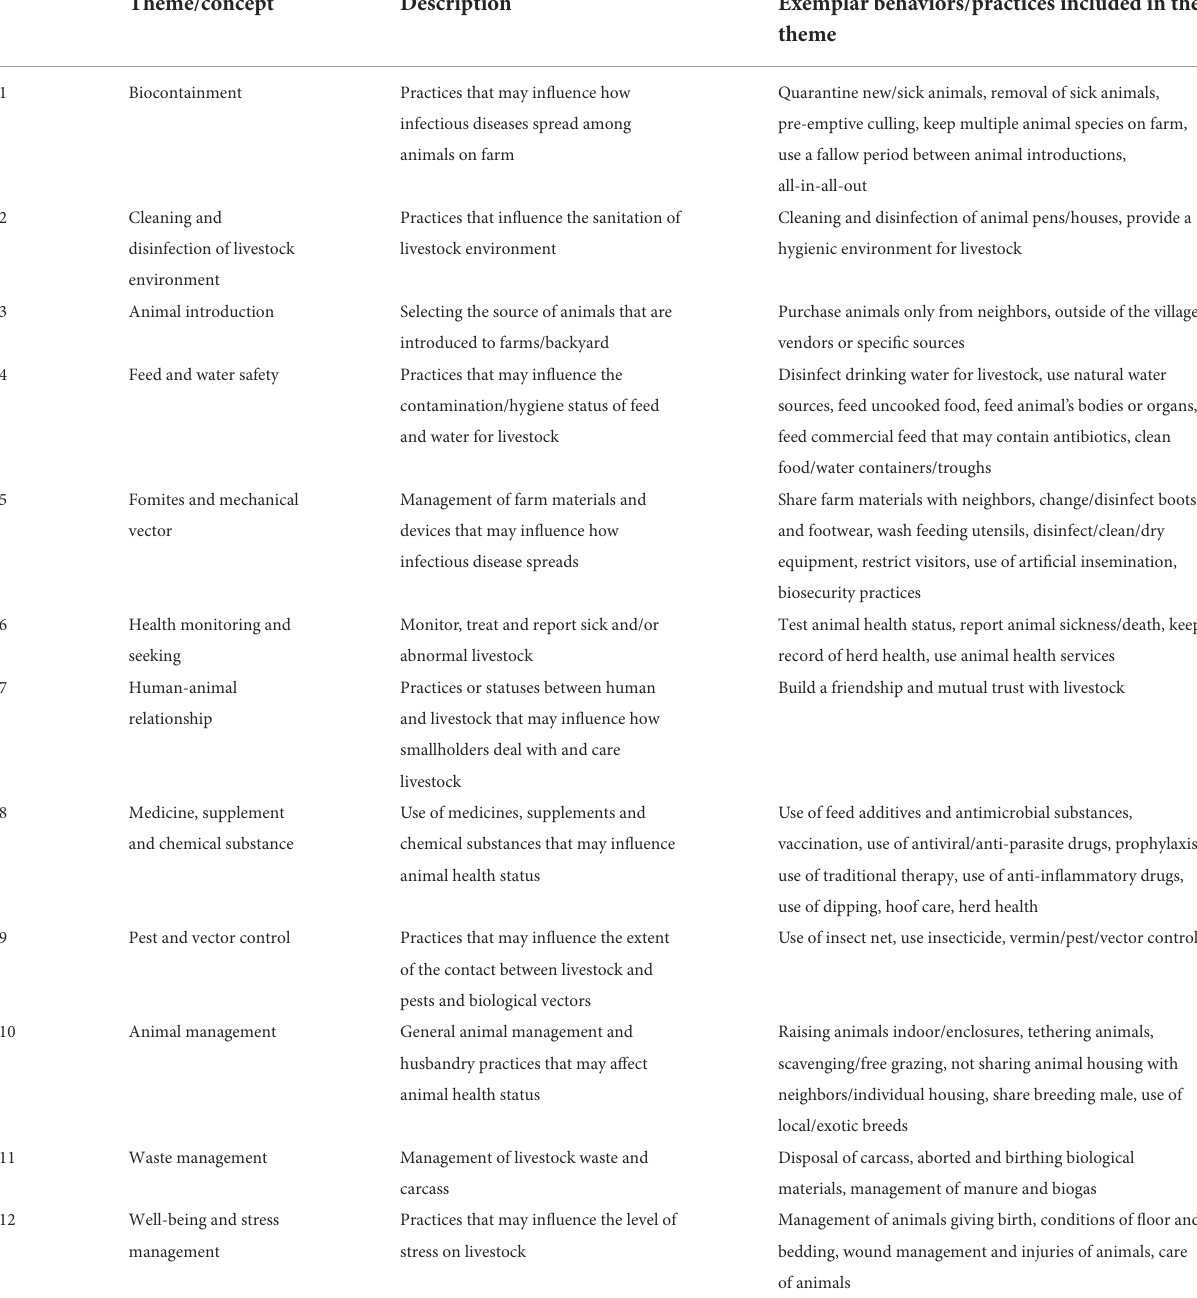
TABLE 2 Themes/concepts for animal health practices that were considered of high relevance in this